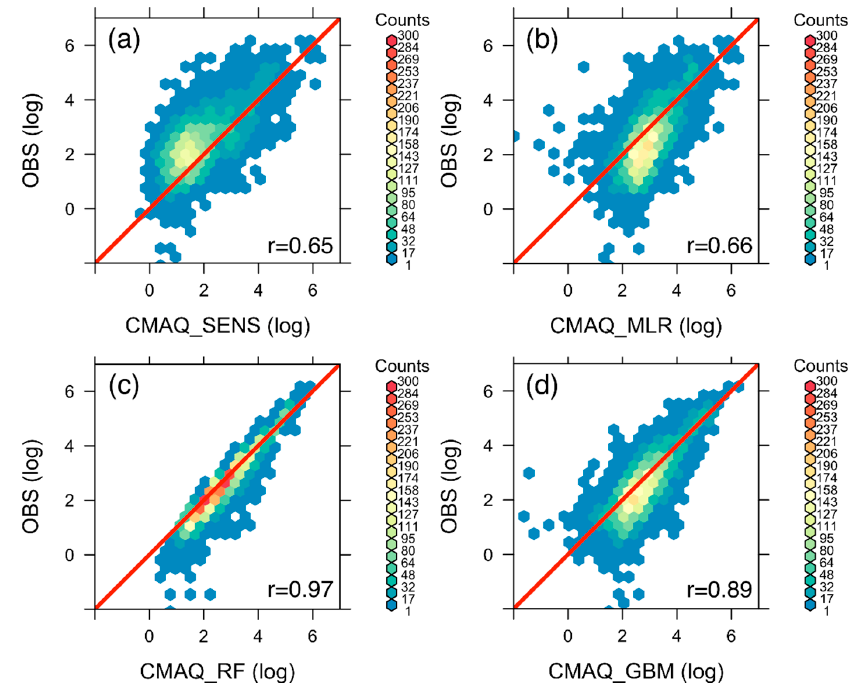
Figure 6. Comparisons of daily PM 2.5 model simulation before and after data integration with AirNow ground observations during the fire smoke pollution episode. ( a ) a scatter plot of PM 2.5 concentrations on a log scale based on the raw WRF-CMAQ SENS simulation and AirNow observations; ( b ) same as ( a ) but based on the MLR data integration method; ( c ) same as ( a ) but based on the RF method; ( d ) same as ( a ) but based on the GBM method. The color shading in all subplots denotes the PM 2.5 data density in terms of sample counts.